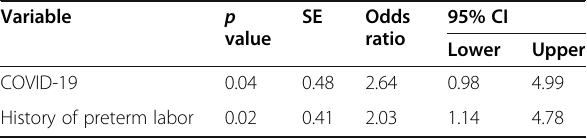
Table 6 Predictive factors of preterm labor in case group based on the result of logistic regression test